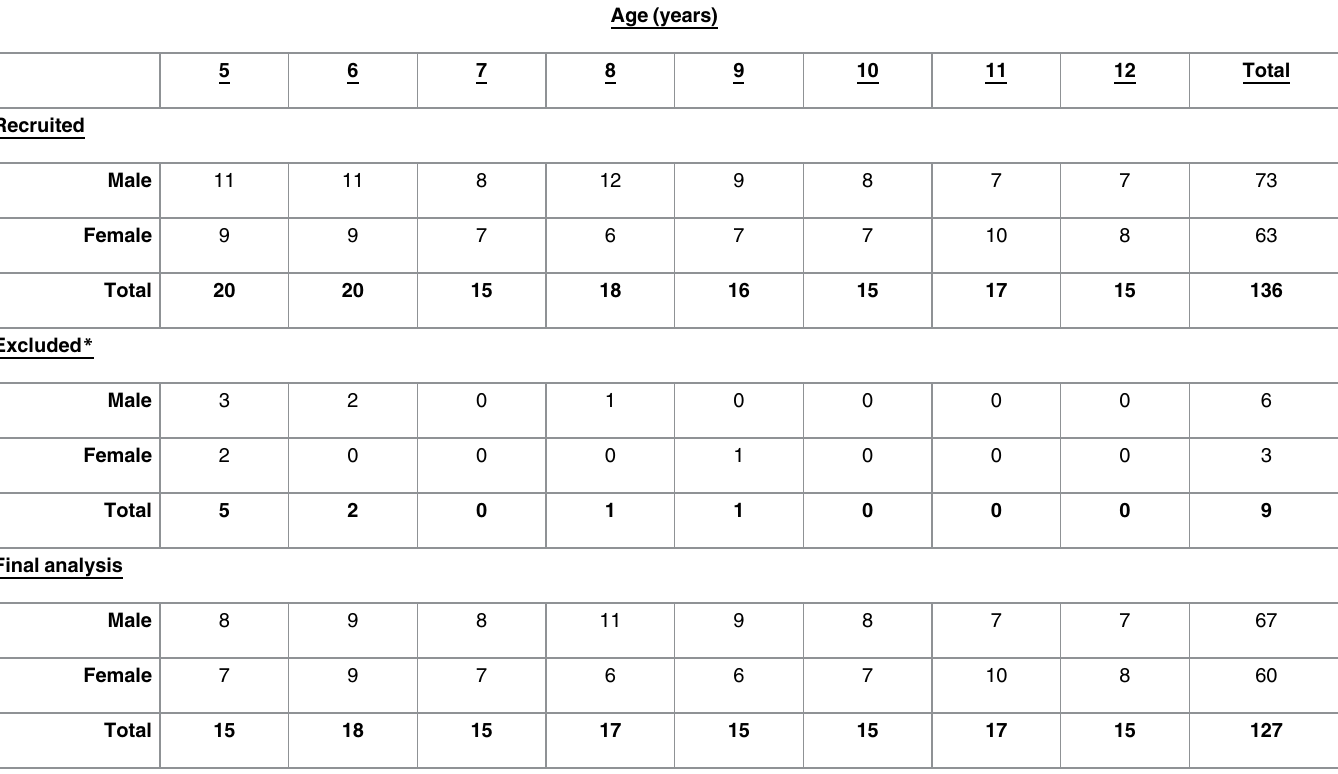
Table 1. Participants by age and